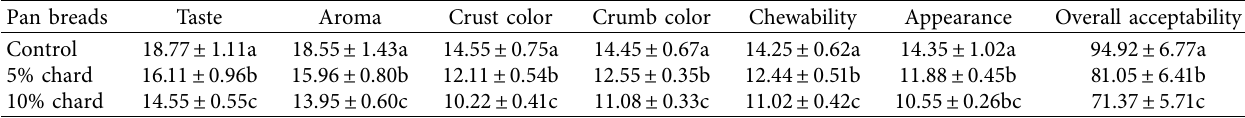
Table 7: Sensory evaluation of pan breads fortified with varying levels of